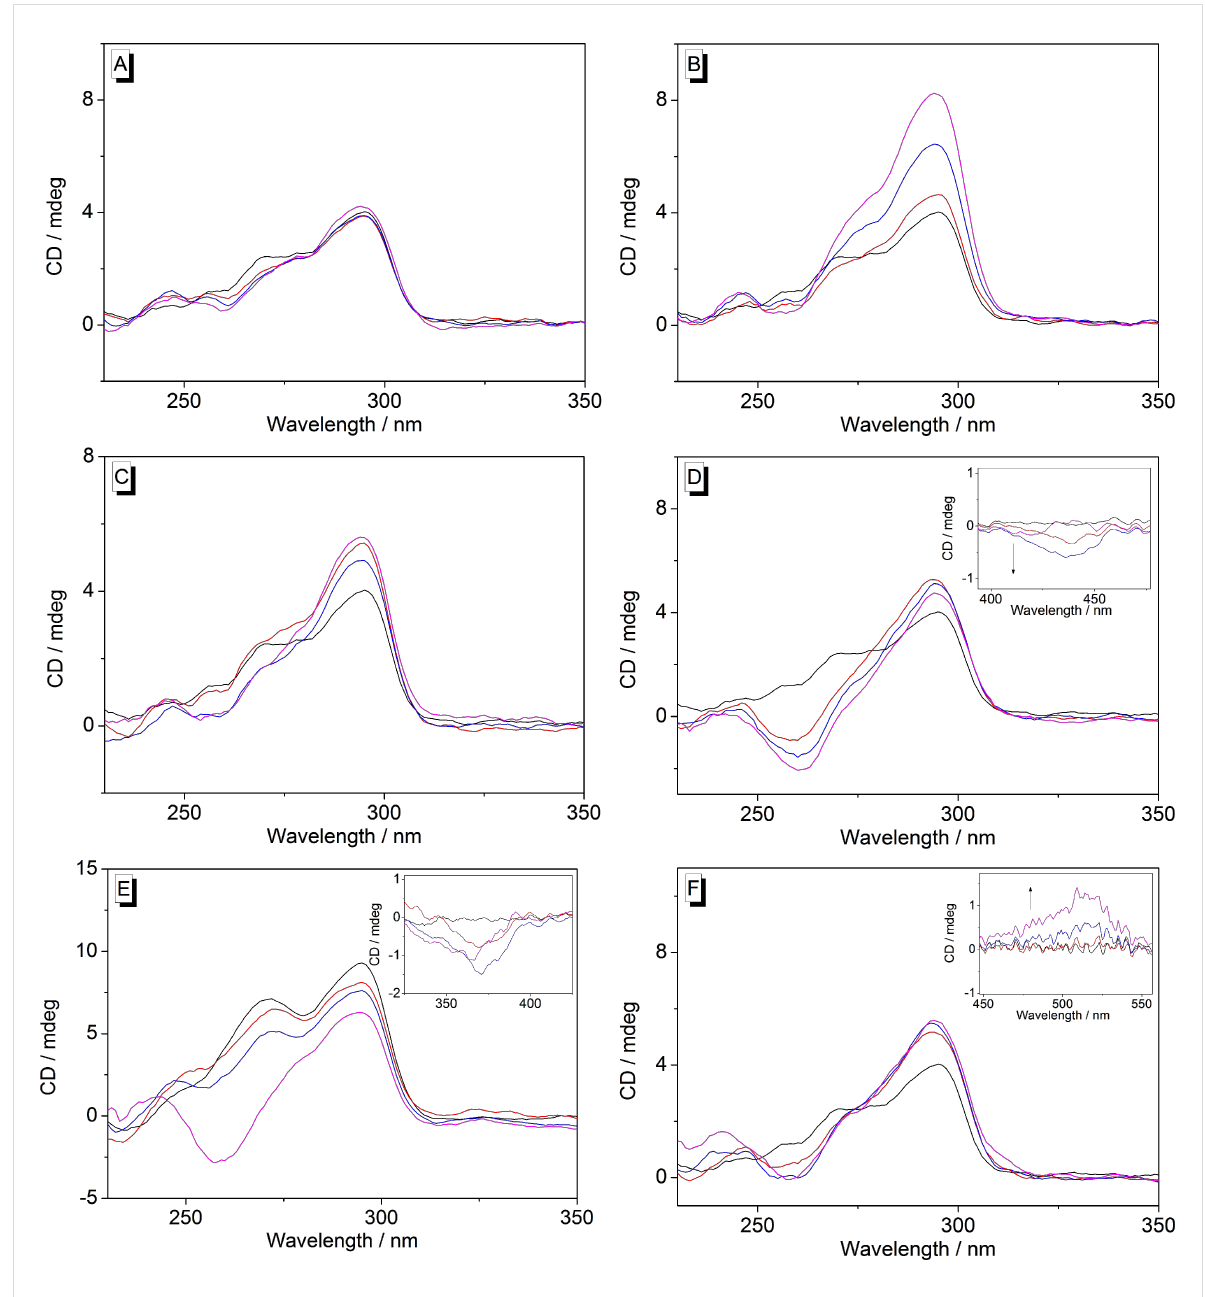
Figure 8: CD spectra of ILPR-DNA a2 in the presence of 1d (A), 1e (B), 2 (C), 4 (D), 5 (E) and 6 (F) at LDR = 0 (black), 0.5 (red), 1 (blue), 2 (magenta); c DNA = 20 μ M in potassium phosphate buffer (95 mM, pH 7.0); T = 20 °C. Inset: Magnified ICD signals of the bound ligands (magnification factor: ca. 10).